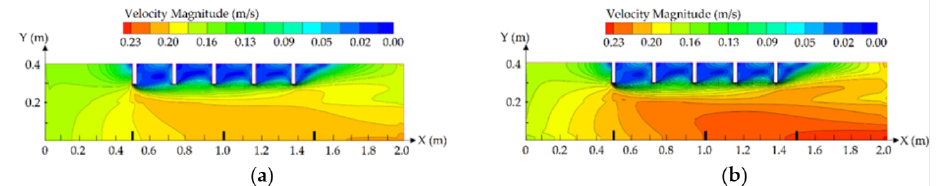
Figure 11. Overview of the simulated velocity magnitude around multiple spur dikes in the experi- mental case: ( a ) case G4a and ( b ) case G5a.